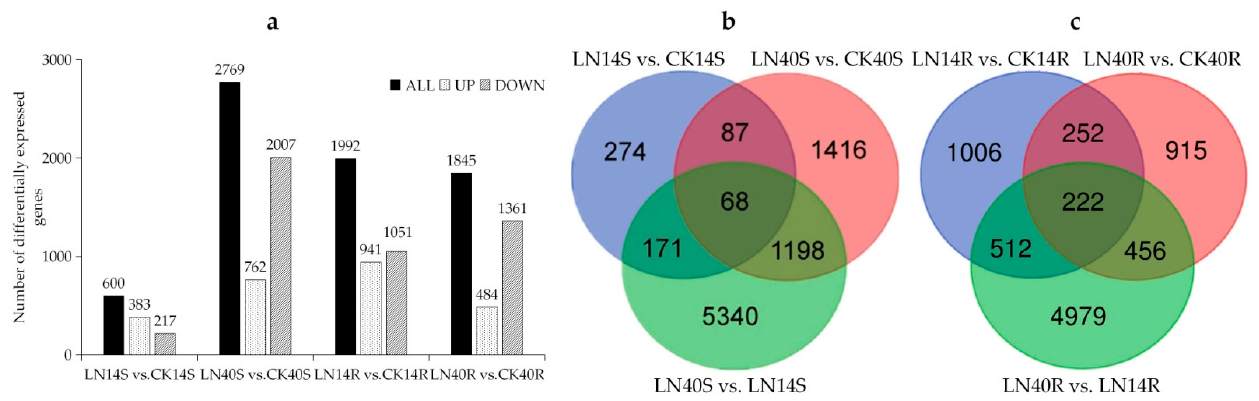
Figure 6. Venn diagrams showing differentially expressed genes (DEGs) in L14 and L40 under LN and CK. ( a ) number of DEGs of in L14 and L40 under LN and CK; ( b ) Venn diagrams of DEGs in the shoots of L14 and L40 when comparing LN vs. CK; and ( c ) Venn diagrams of DEGs in the roots of L14 and L40 when comparing LN vs. CK. Treatment groups are LN14S (L14’shoot-LN), CK14S (L14’ shoot-CK), LN40S (L40’ shoot-LN), CK40S (L40’ shoot-CK), LN14R (L14’ root-LN), CK14R